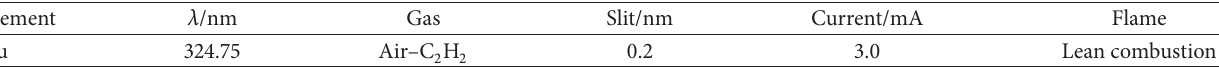
Table 2: Instrument parameters for AAS.